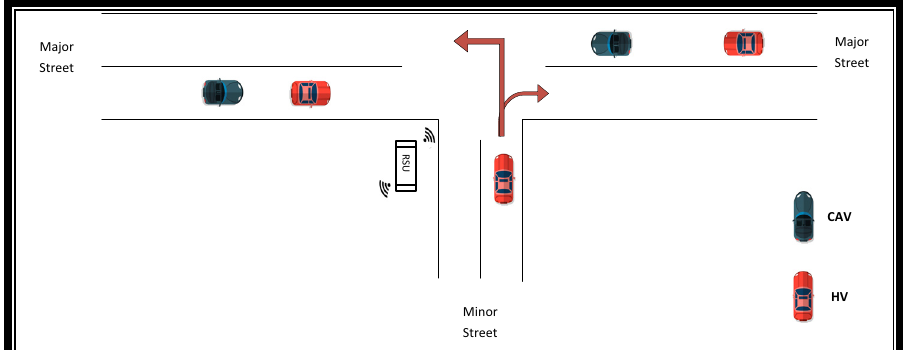
Figure 3: Layout of the intersection